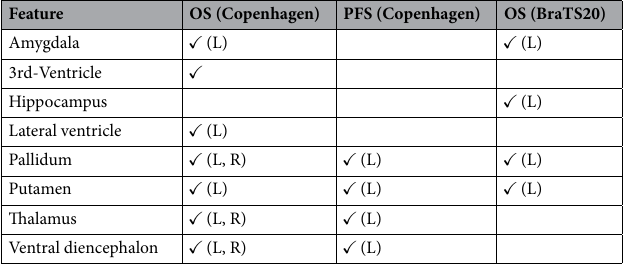
Table 1. Brain structures whose Hd95 feature was selected by the feature selection method are marked with a checkmark, accompanied by L and R denoting left and right-sided structures. Shown for both the Copenhagen and BraTS20 datasets.